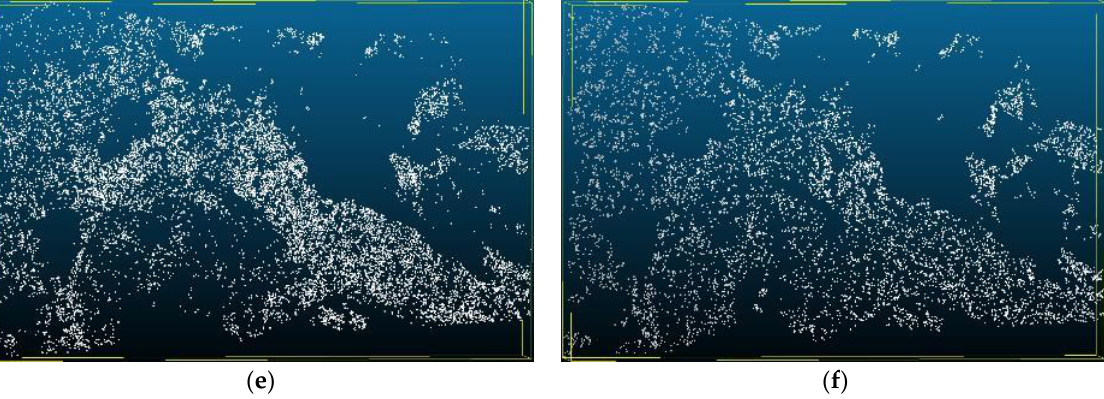
Figure 8. The generated sparse point cloud by the proposed procedure (( a ), ( b ), and ( c )) and Agisoft (( d ), ( e ), and ( f )) from the first, second, and third datasets, respectively.